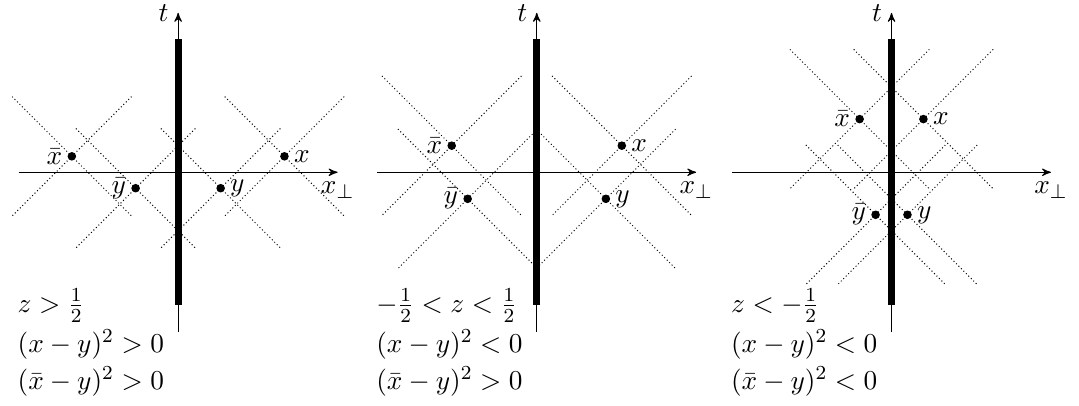
Figure 4 . Causal structure for di(cid:11)erent values of z . For simplicity of illustration ~x and ~y are chosen to point into the direction of time. Dotted lines indicate